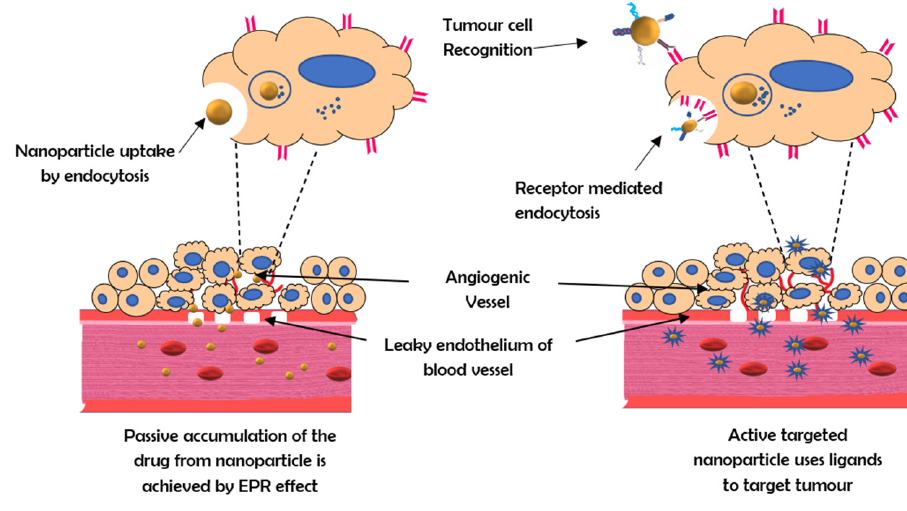
Figure 1. The mechanism of active and passive targeting by nanocarriers .